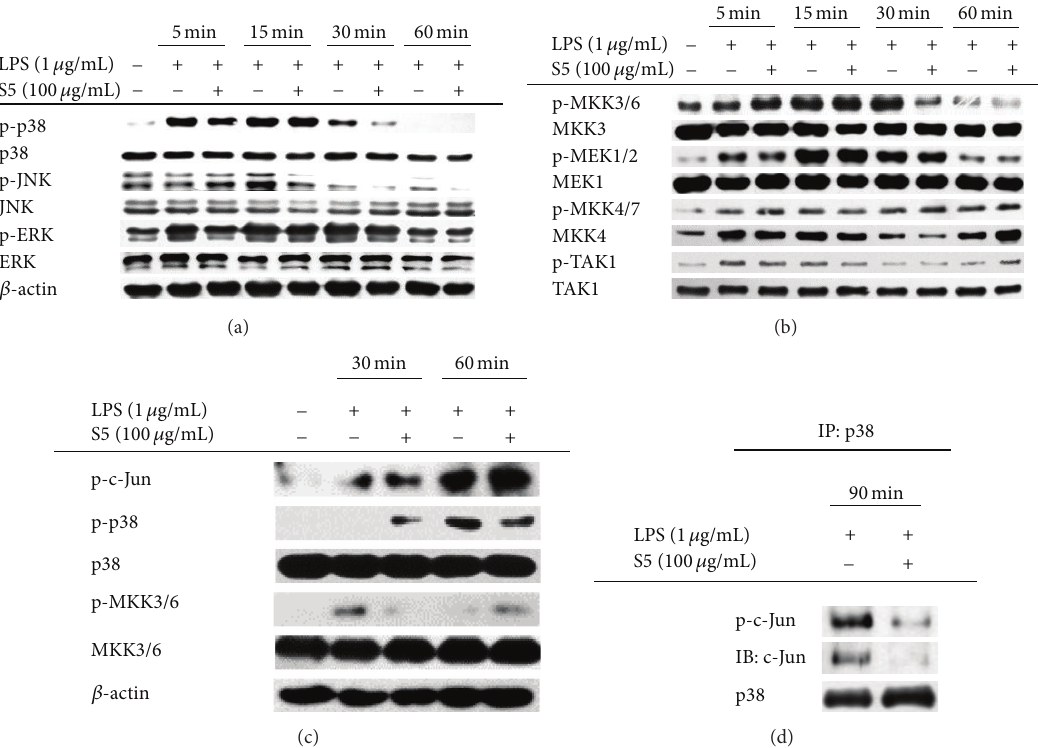
Figure 4: Effects of the S5 peptide on the activation of the AP-1 signaling pathway. (a and b) Phosphoprotein and total protein levels of p38, JNK, ERK, MEK1/2, MKK3/6, MKK4/7, TAK1, and 𝛽 -actin in the lysates of RAW264.7 cells were analyzed by Western blotting. (c) The levels of total and phosphorylated c-Jun, p38, MKK3/6, and 𝛽 -actin in lysates from peritoneal macrophages were determined by immunoblotting analysis. (d) The effect of the S5 peptide on the c-Jun/p38 interaction was determined by immunoprecipitation analysis with antibody against p38 and by immunoblotting analysis with antibodies against p-c-Jun, c-Jun, and